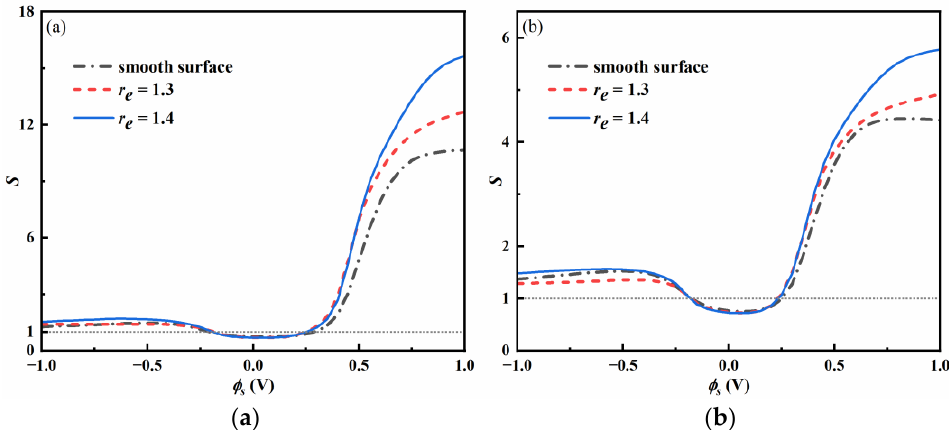
Figure 7. Selectivity of [BF 4 ] − over [Tf 2 N] − as a function of 𝜙 𝑠 . ( a ) X BF4 = 0.2 and ( b ) X BF4 =